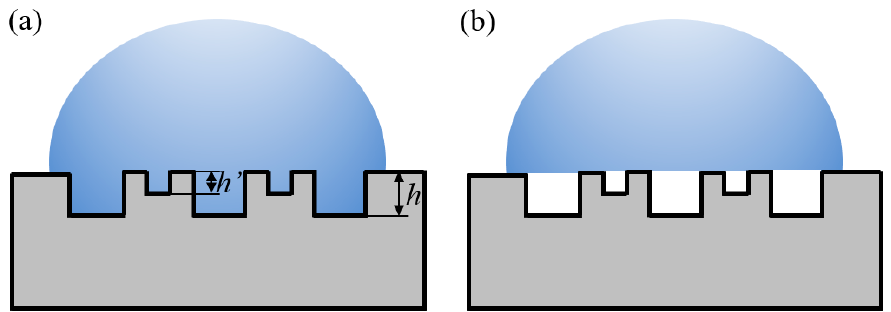
Figure 12. Wetting state of droplet on cruciform secondary microstructure: ( a ) Wenzel state; ( b ) Cassie state.